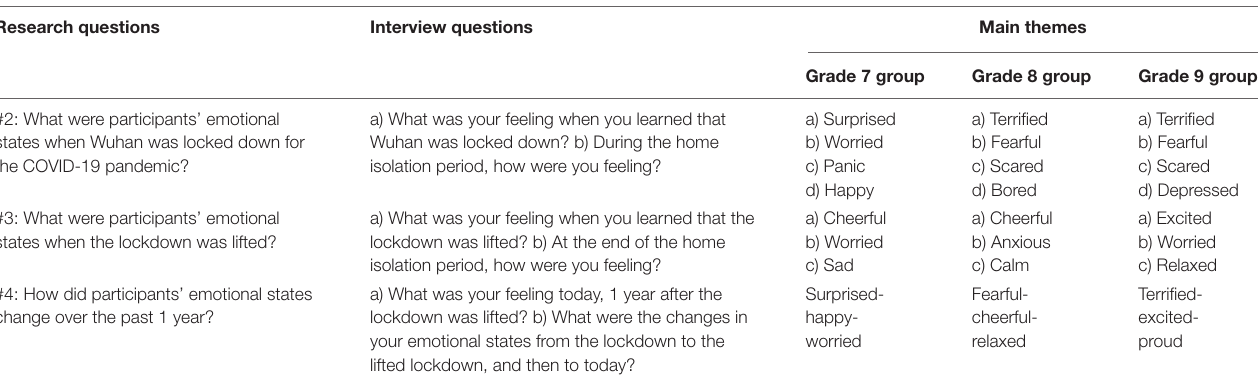
TABLE 2 | Main themes of focus group interviews for research questions #2, #3, and